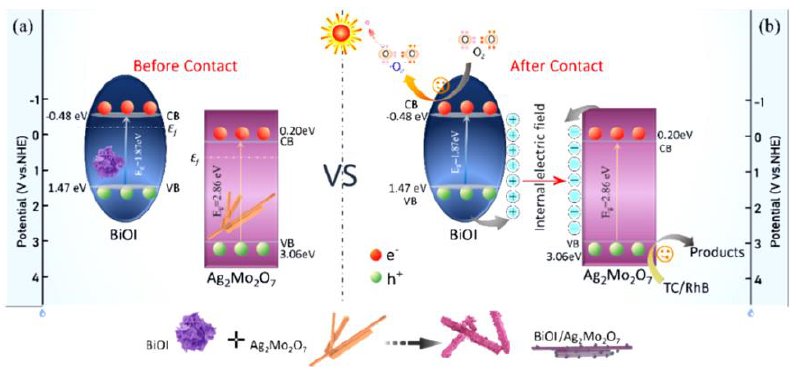
Figure 13. A plausible photocatalytic reaction mechanism diagram for an n – n Ag 2 Mo 2 O 7 /BiOI nanostructure. Reproduced with permission from [151]. Copyright 2022 Elsevier. nanostructure. Reproduced with permission from [151]. Copyright 2022